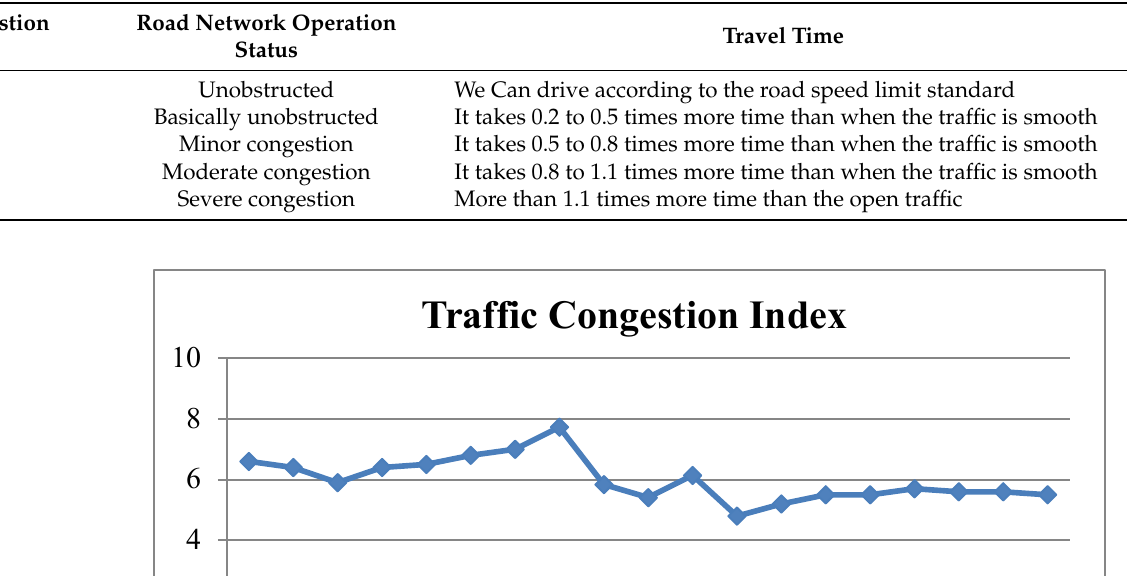
Table 3. Traffic congestion index corresponding to travel time.